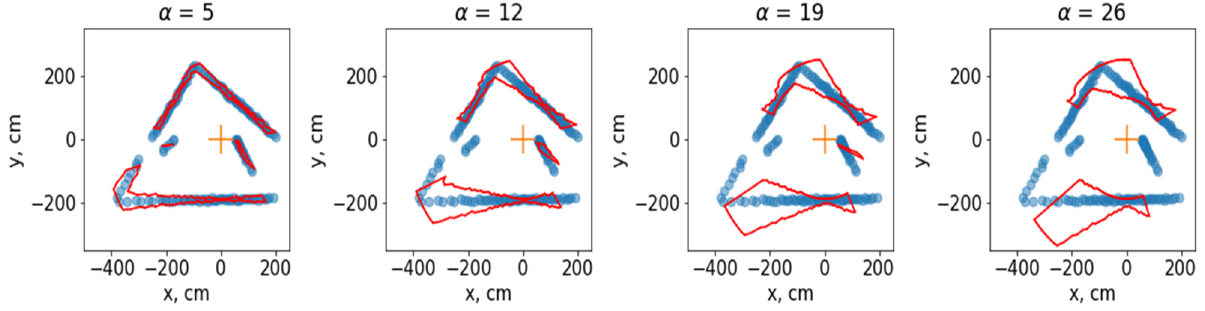
Figure 4. Each of the figures in orange shows the position of the LiDAR sensor, which coincides with the beginning of the coordinate system. The obstacle prediction is shown in red. The sensor points are shown in blue. Each figure shows the algorithm’s result in red polygons (cluster contours) at a particular configuration α .